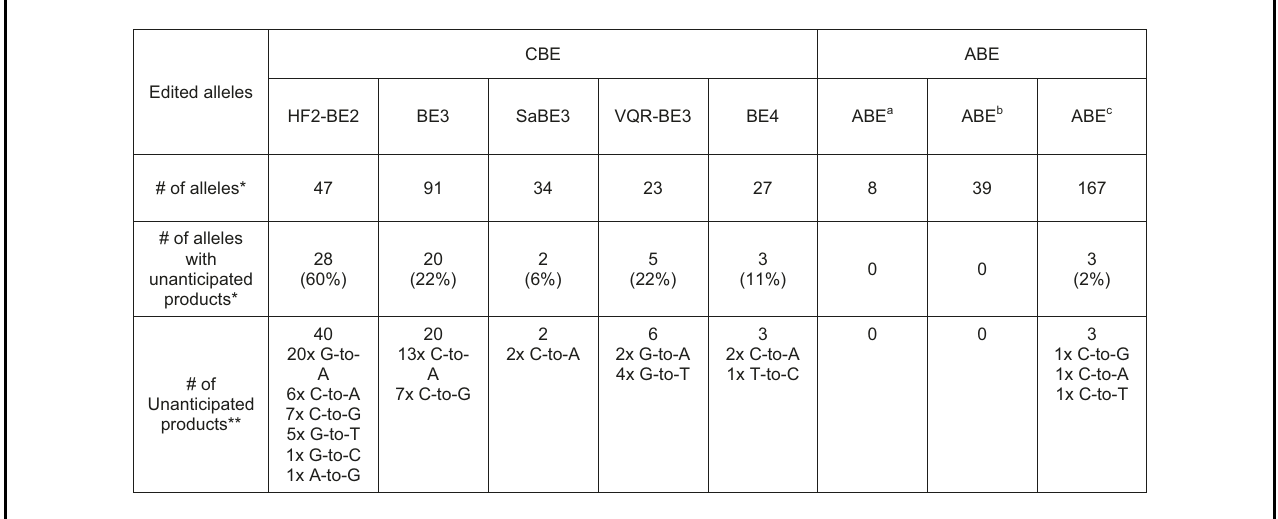
Table 2 Summary of unanticipated products caused by various base editors